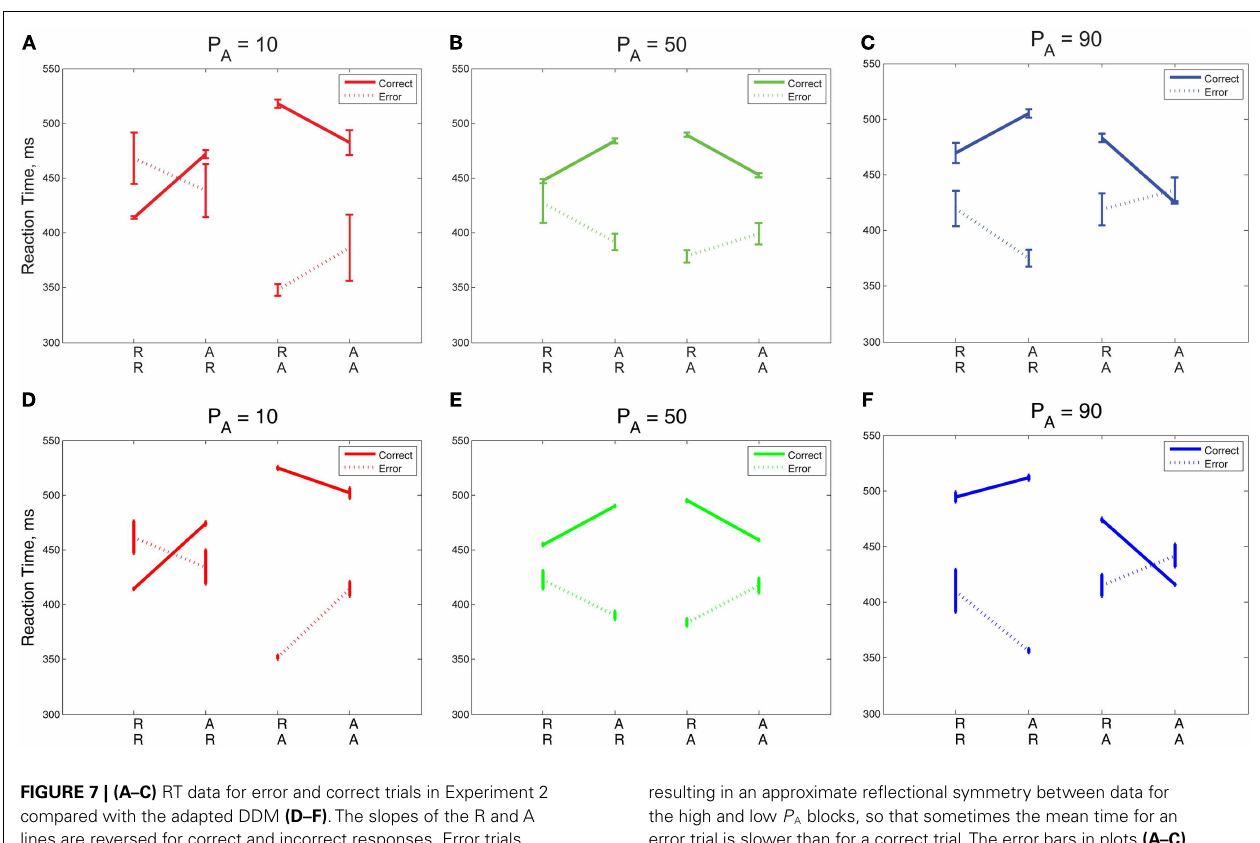
FIGURE 7 | (A–C) RT data for error and correct trials in Experiment 2 compared with the adapted DDM (D–F) .The slopes of the R and A lines are reversed for correct and incorrect responses. Error trials incur faster responses on unexpected trials (RA, AR) than on expected trials (RR, AA); this trend is reversed for correct responses. For low P A , the R lines overlap, and for high P A , the A lines overlap,